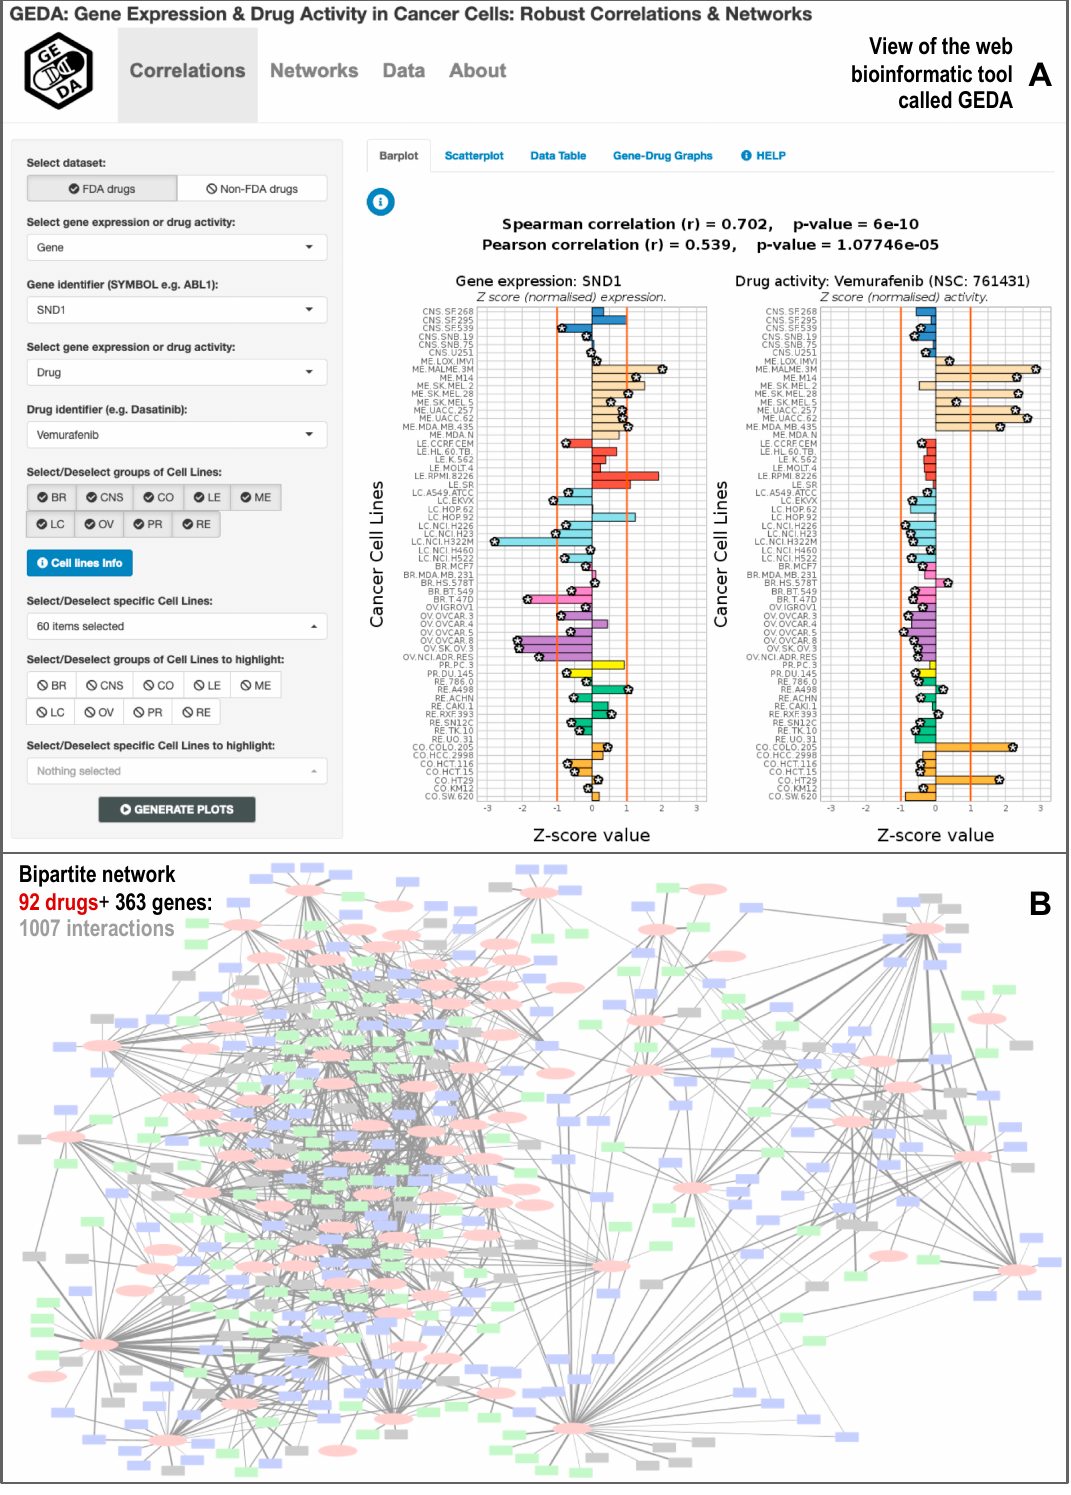
Figure 4. Bioinformatic web-tool called GEDA (Gene Expression and Drug Activity) that includes the database of significant correlations between cancer drugs and gene targets calculated using the information of 60 cancer cell lines (NCI-60). The resource presents ( A ) views of the data of each significant drug-target pair, using barplots and scatterplots; and ( B ) view of the bipartite networks generated between 92 Food and Drug Administration (FDA)-approved cancer drugs and 363 cancer human genes.